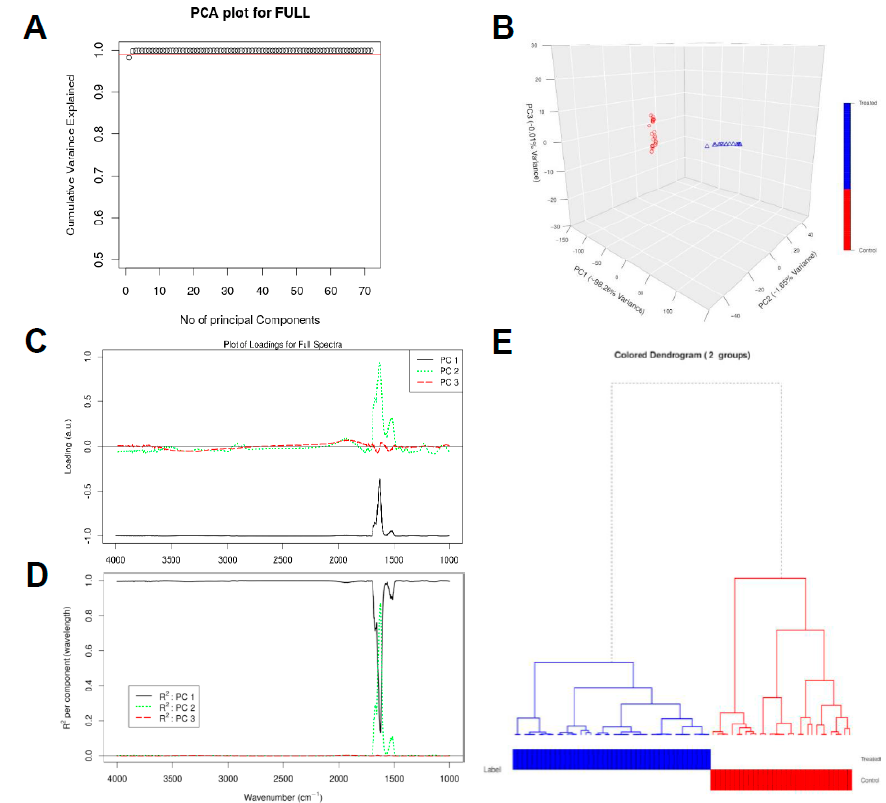
Figure 3. Chemometric analysis of FTIR experimental data on the full spectral range (4000–1000 cm − 1 ). Amount of variance captured by PCs ( A ), PCA score plot ( B ), loading plots for the spectral data ( C ), squared correlation for the first three PCs for the spectral collection ( D ), and hierarchical clustering of the spectra for the different experimental samples ( E ).